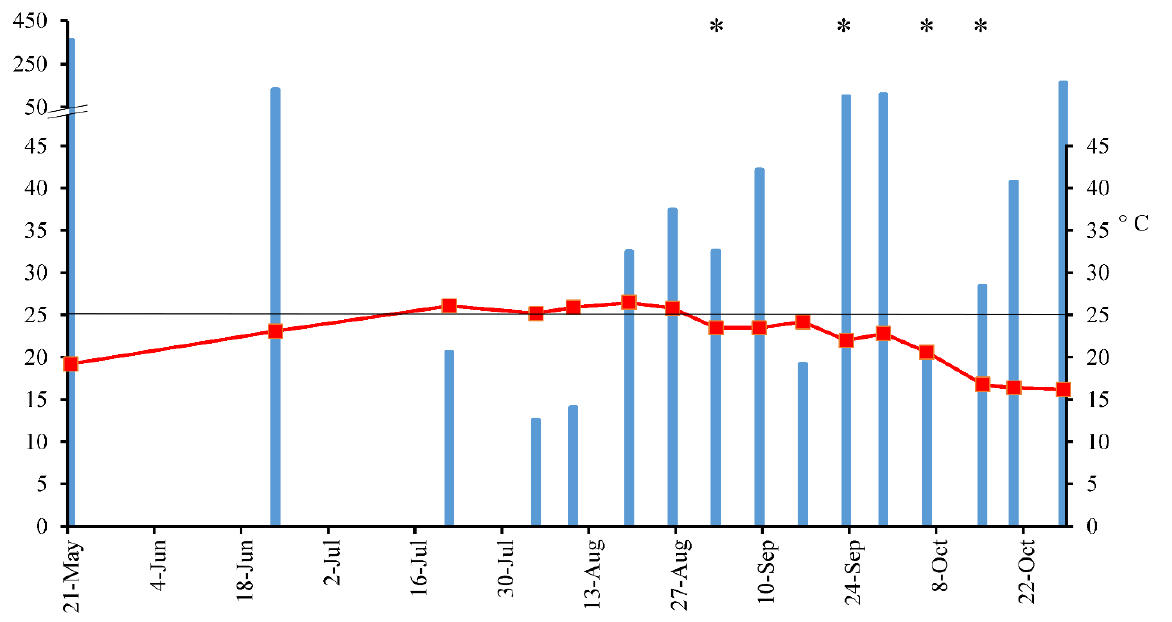
Figure 4. Temporal variability of the N:P ratio (bars, left y-axis) and water temperature (line, °C, right y-axis) at the Passetto station. The horizontal line represents both (i) the upper N:P ratio threshold, below which better nutrient conditions are supplied to Ostreopsis cf. ovata growth, and (ii) the lower temperature threshold, permitting the bloom ’s onset [66]. * denotes dates when sea conditions could potentially disturb the development of the bloom (Douglas scale ≥ 2, i.e. , wave heights from 0.1 to 2.5 m, ranging from smooth to moderate).